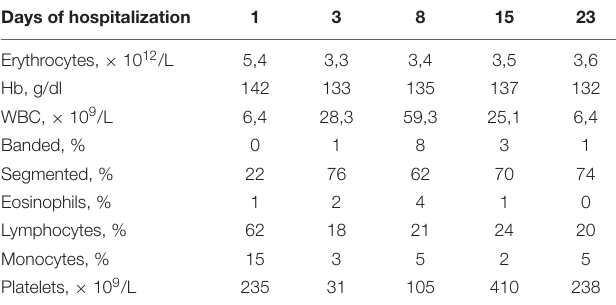
TABLE 2 | Complete blood cells counts during